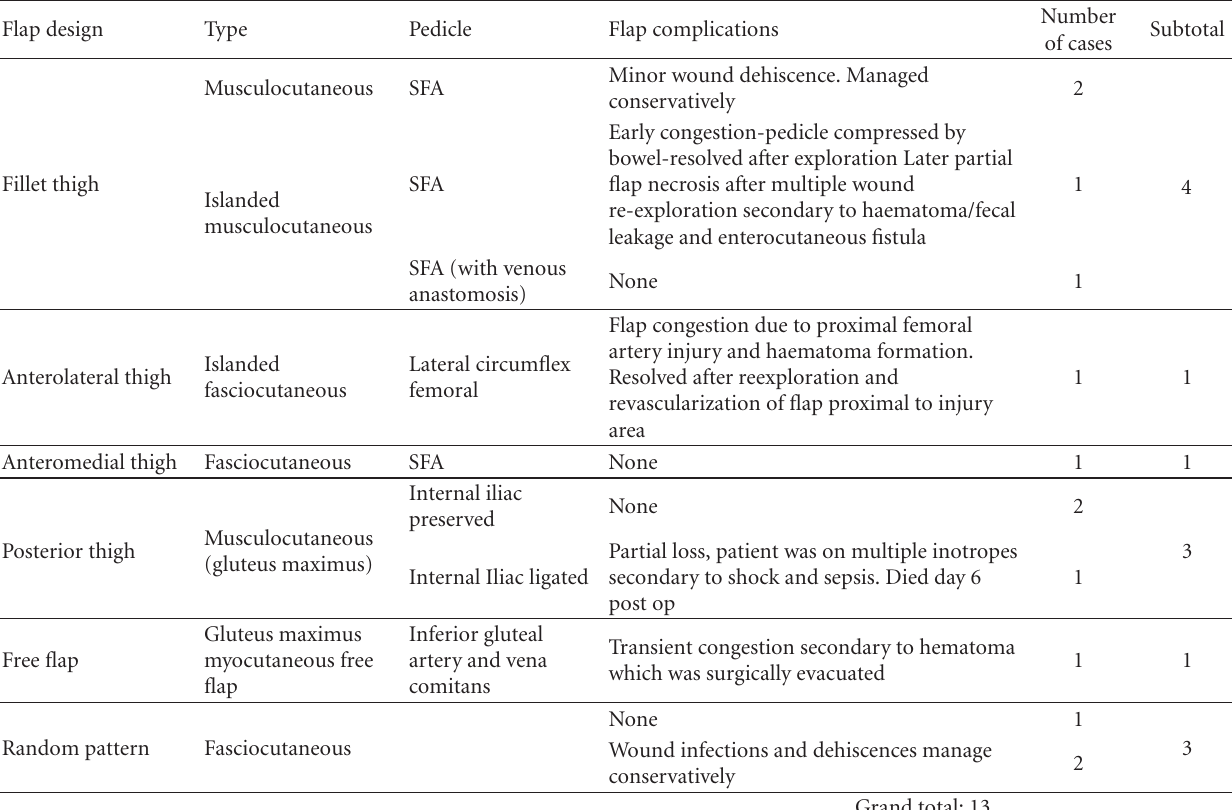
Table 2: Type of flap used and their related